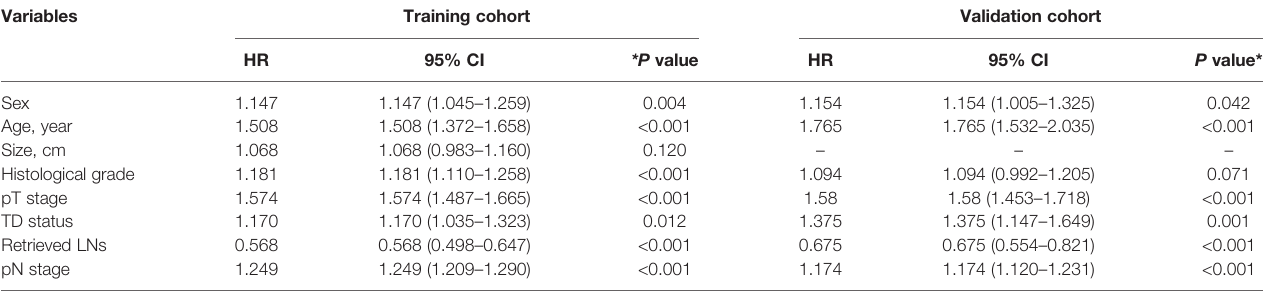
TABLE 2 | Multivariate survival analyses of patients with colorectal cancer in the training and validation cohorts.